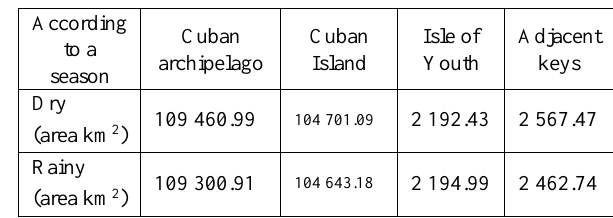
Table 2. Estimation according to results of the research work done for